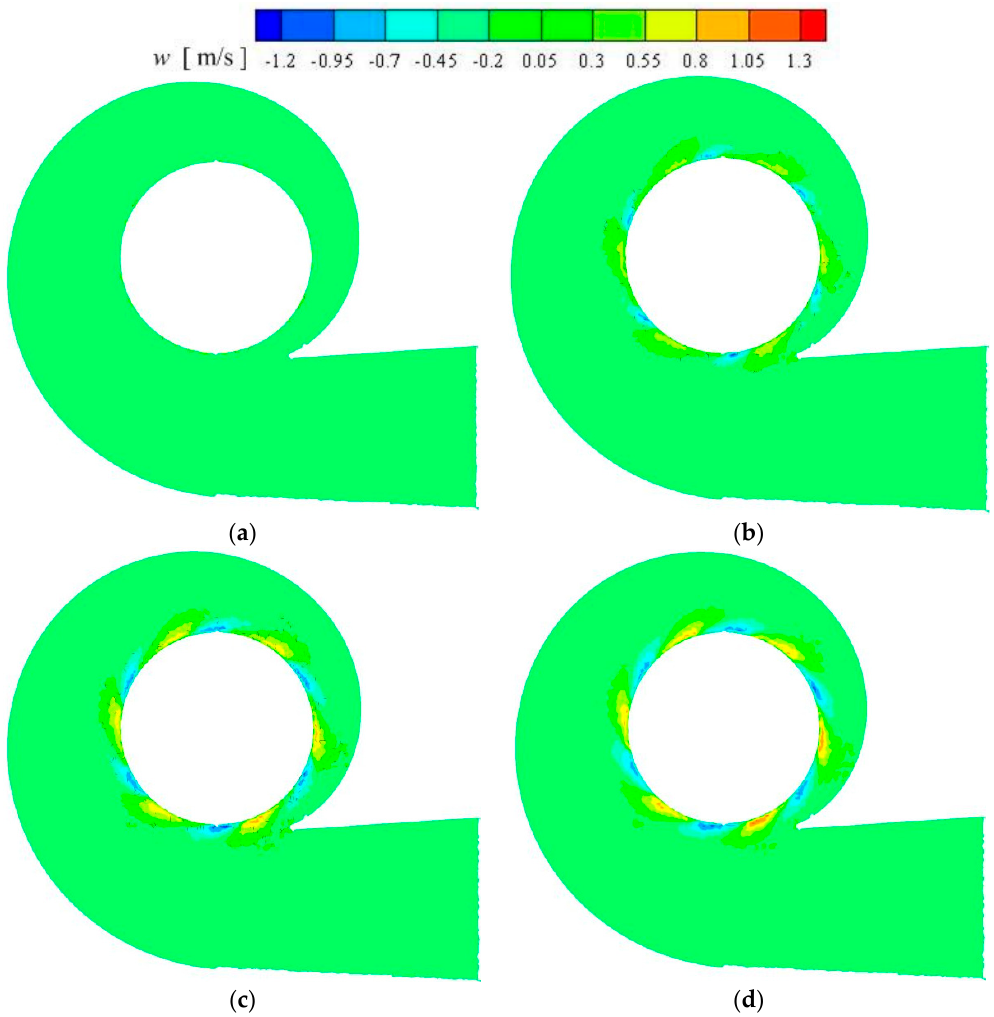
Figure 8. The instantaneous axial velocities at middle-span plane of volute at t = 0.92 s. ( a ) Case0; ( b ) Case10; ( c ) Case20; ( d ) Case30.